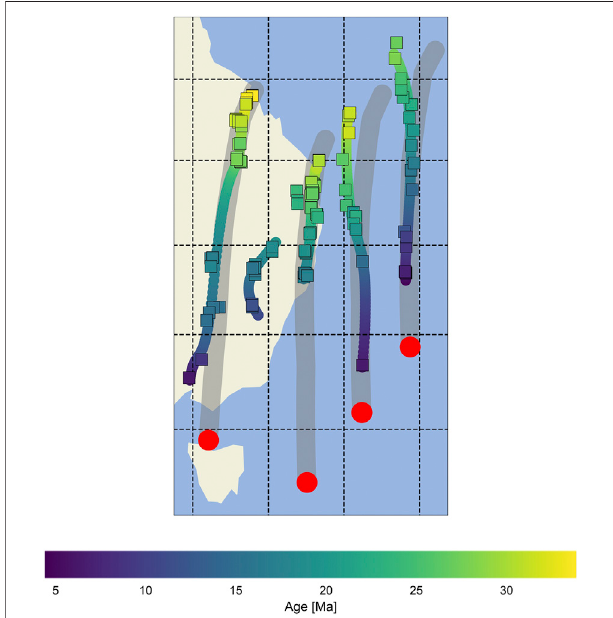
FIGURE 5 | Spline fi ts to eastern Australian hotspots based on geochronologic data (squares, Ashley et al., 1995; McDougall et al., 1981; McDougall and Duncan, 1988; Cohen et al., 2007; McQueen et al., 2007; Cohen et al., 2008; Knesel et al., 2008; Mortimer et al., 2010; Cohen et al., 2013; Crossingham et al., 2017; Mortimer et al., 2018; Crossingham etal.,2018a;Crossinghametal.,2018b;Sutherlandetal.,2012).Presentday positions are shown in red, based upon motion paths (in gray) derived from Doubrovine et al. (2012) ( Table 1